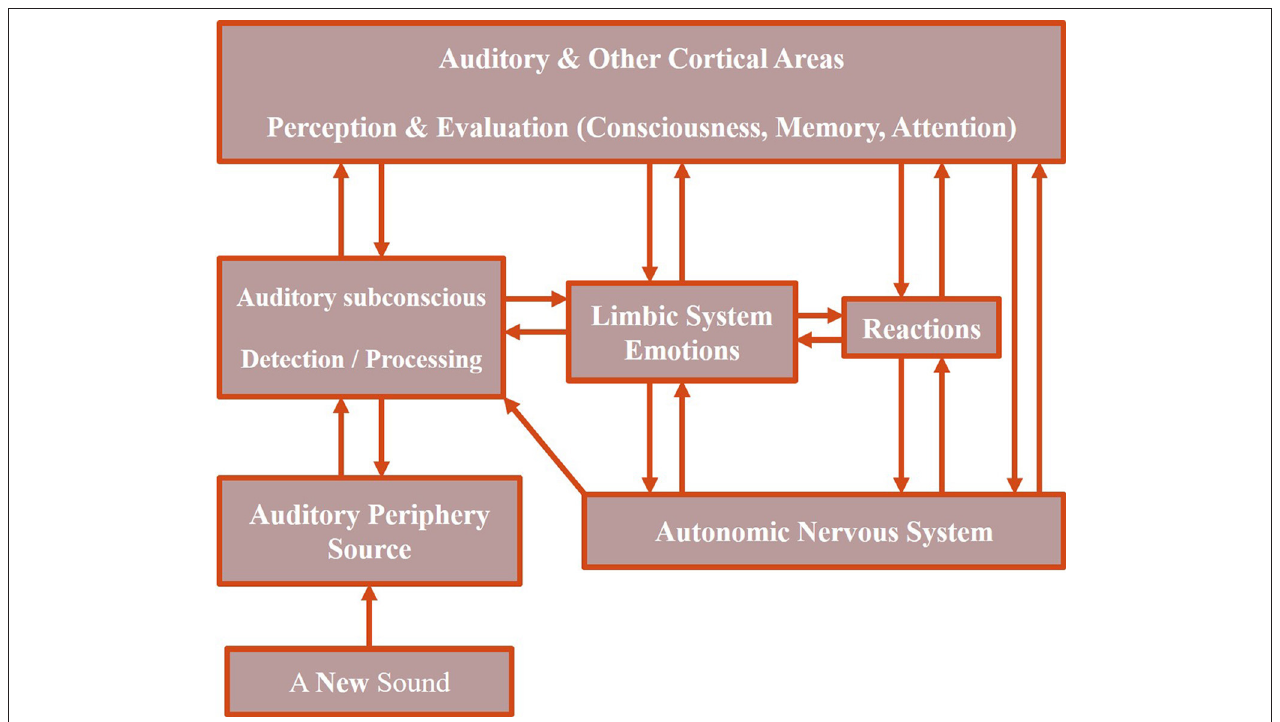
FIGURE 1 | Neurophysiological model of tinnitus. Adapted from Jastreboff and Jastreboff